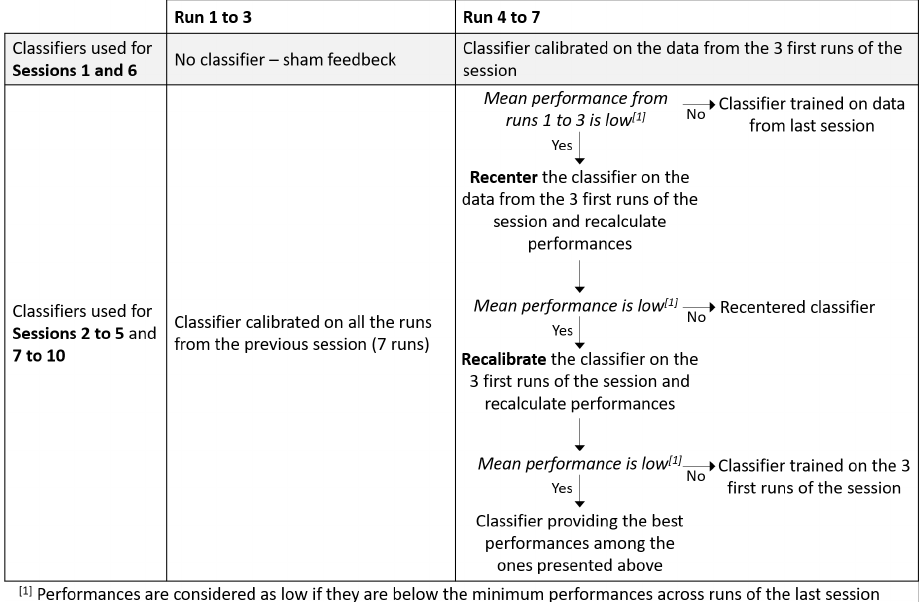
Figure 4. Classifiers used for each of the sessions and